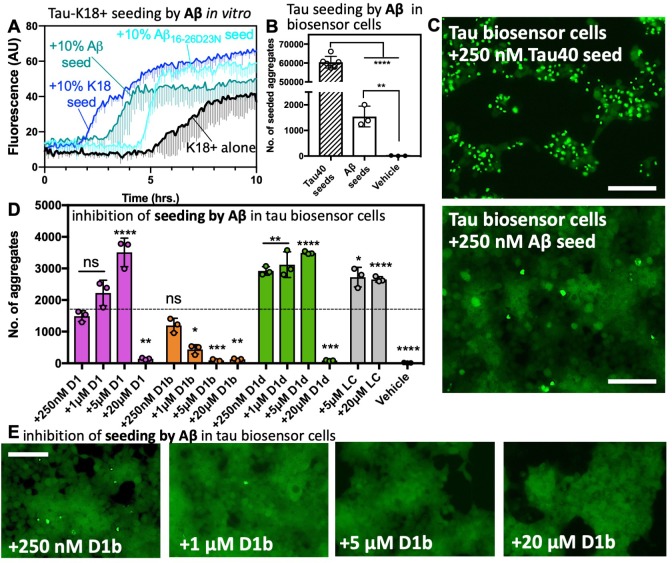
Tau aggregation is seeded by Aβ and reduced by structure-based inhibitors.(A) 50 μM tau-K18+ was seeded with 10% monomer equivalent of pre-formed fibrils of Aβ1–42, Aβ16-26 D23N or tau-K18 under shaking conditions at 700 RPM at 37°C in PBS. Fibril formation was monitored using ThT fluorescence. Error bars below show the standard deviation of the average of three technical replicates. (B) The number of intracellular aggregates present in tau-K18CY biosensor cells normalized to cell confluence seeded by the addition of 250 nM tau40 or 250 nM Aβ1–42 fibrils. Error bars show the standard deviation of the mean of technical replicates (n = 3; ****, p=0.0001 using an ordinary one-way ANOVA- Dunnett’s relative to leftmost column, and **, p=0.0028 in unpaired t test of Aβ vs. vehicle) (C) Representative images of seeded cells from B at 10x magnification, scale bar 100 μm. (D and E). Concentration dependent inhibition of Aβ1–42 induced seeding of tau aggregation in tau-K18CY biosensor cells. (D) Average seeding by Aβ as a function of indicated inhibitor concentration. Error bars show the standard deviation of the mean of technical replicates (n = 3; ns = not significant; *, p<0.02; **, p<0.005; ***, p<0.001; ****, p<0.0001 using an ordinary one-way ANOVA- Dunnett’s relative to leftmost column), and the dotted line shows the mean number of aggregates from untreated Aβ1–42 fibrils. (E) Representative images of tau-K18CY biosensor cells showing the concentration-dependent effect of D1b on seeding. Cells are shown at 10X magnification, scale bar 100 μm.10.7554/eLife.46924.020Figure 5—source data 1.Tau biosensor seeding data points—Aβ and other amyloid fibrils with and without inhibtors.